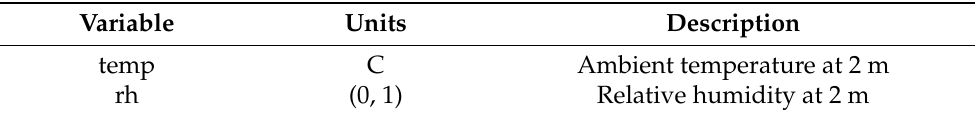
Table 2. Load forecasting model numerical weather prediction (NWP) input